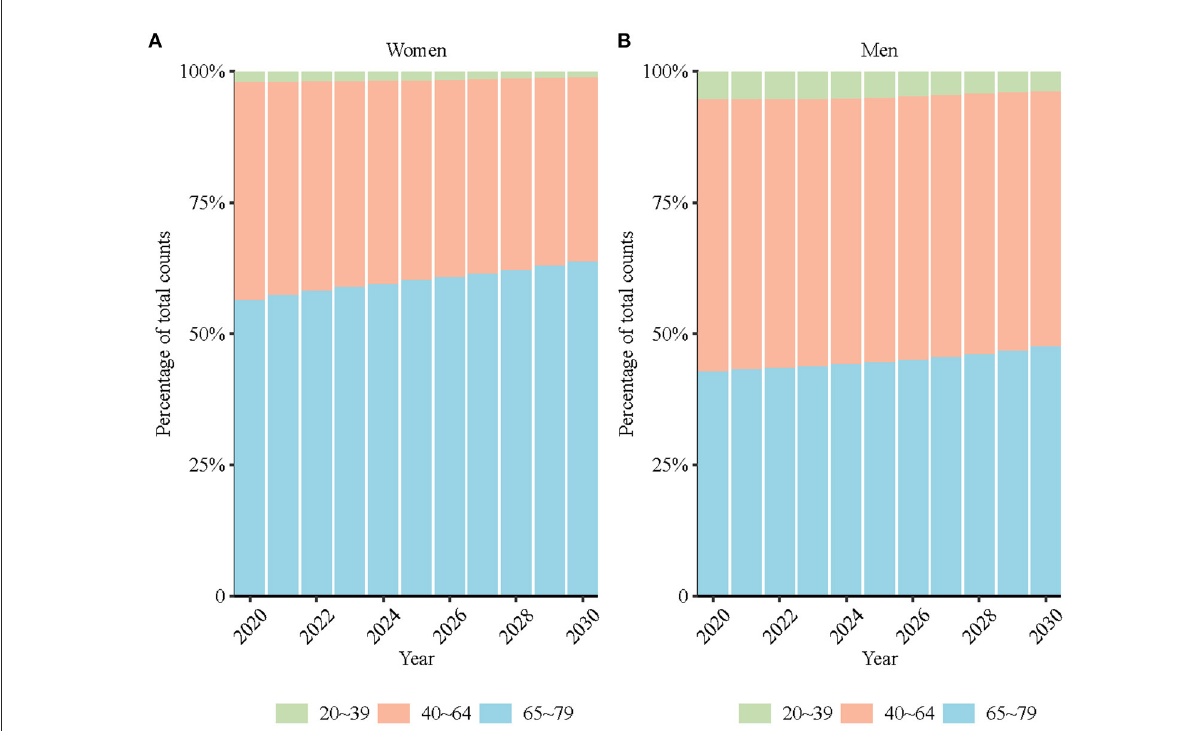
FIGURE6 Percentage of projected obesity-attributable stroke deaths for women (A) and men (B) in three age groups (20–39, 40–64,